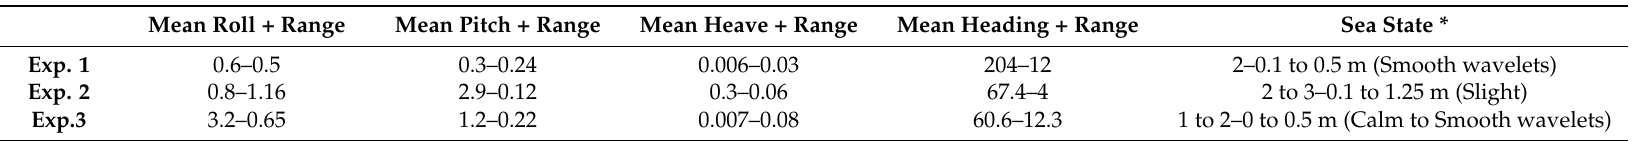
Table 9. Motion sensor derived variables used as a form of quality control on the datasets. The sea state (using the World Meteorological Organization scale) is also reported Figures in degrees ( ◦